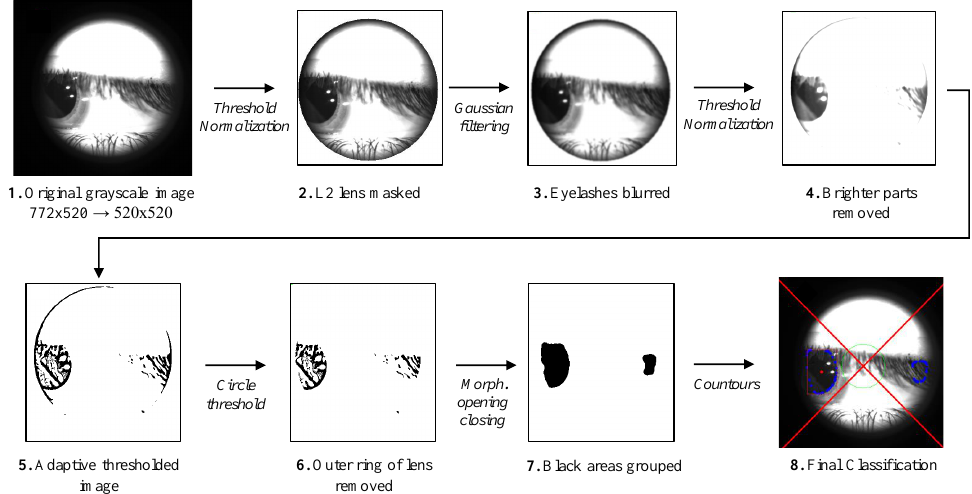
Figure 5. Flowchart of the image processing steps performed by the developed ES algorithm as detailed in Section 4.1. The final detection of the pupil is reported in the last image in which the pupil center (red dot) position, in respect to red diagonals and the green circle (see Figure 3) and the aspect ratio of the bounding box (red bounding box) are evaluated; the picture is labeled with the class “left” by the